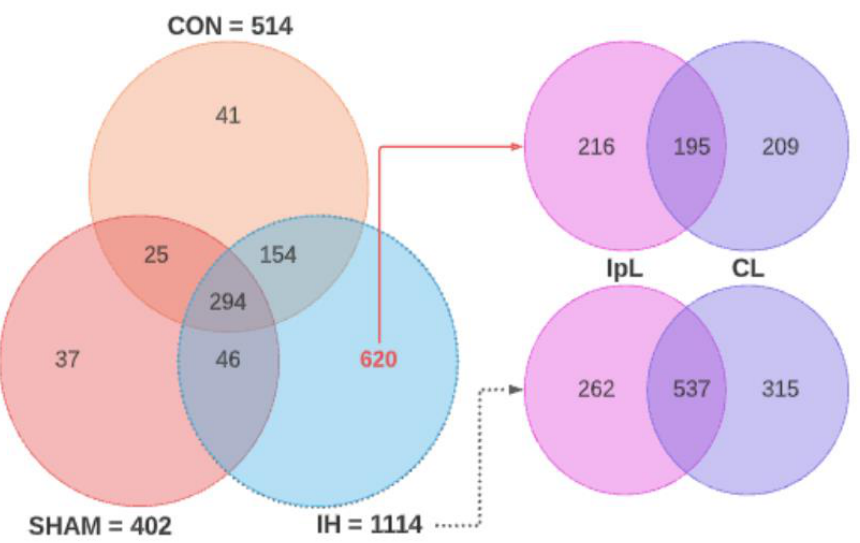
Figure 3. Venn diagrams showing the total number of porcine brain proteins identified and their distribution along the ipsilateral and contralateral sides for pigs with IH.